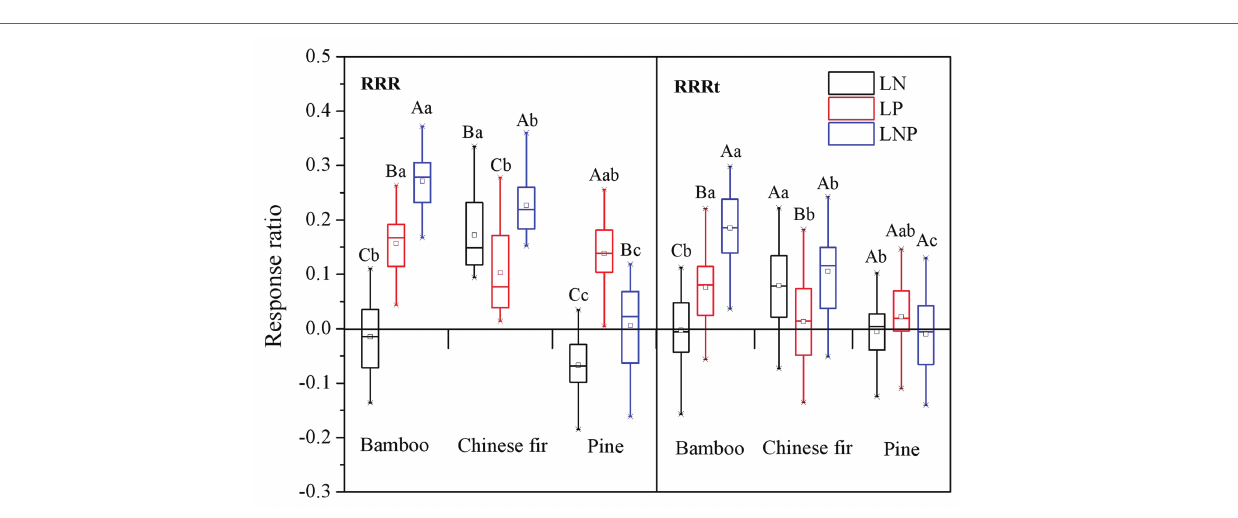
FIGURE 6 | Response ratios (RRR and RRRt) under localized nutrient supply treatments (LN, LP, and LNP) in comparison to the uniform nutrient supply (UNP). Different lowercase letters denote significant differences among species ( p < 0.05). Different capital letters denote significant differences among treatments ( p < 0.05). RRR, root response ratio; RRRt, response ratio of total root